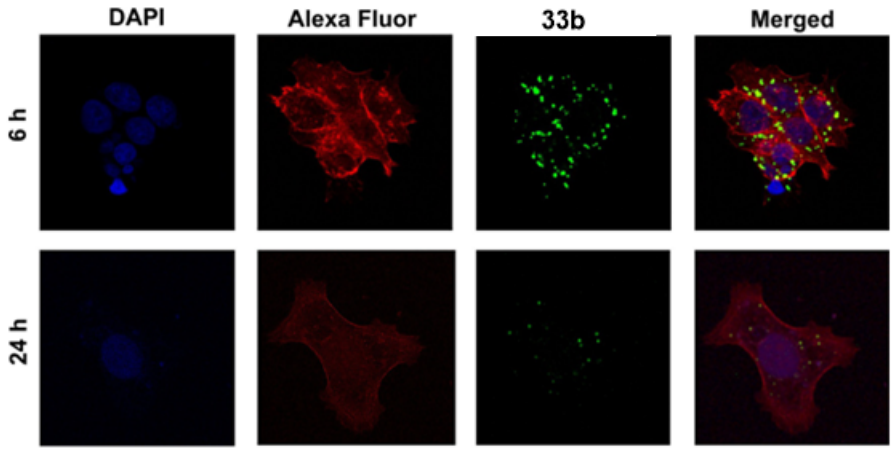
Figure 27. Confocal fluorescence images of MCF-7 cells incubated with DAPI, Alexa FluorS 555- Phalloidin, and imidazopyrimidine compound 33b after 6 and 24 h. Adapted from [71].